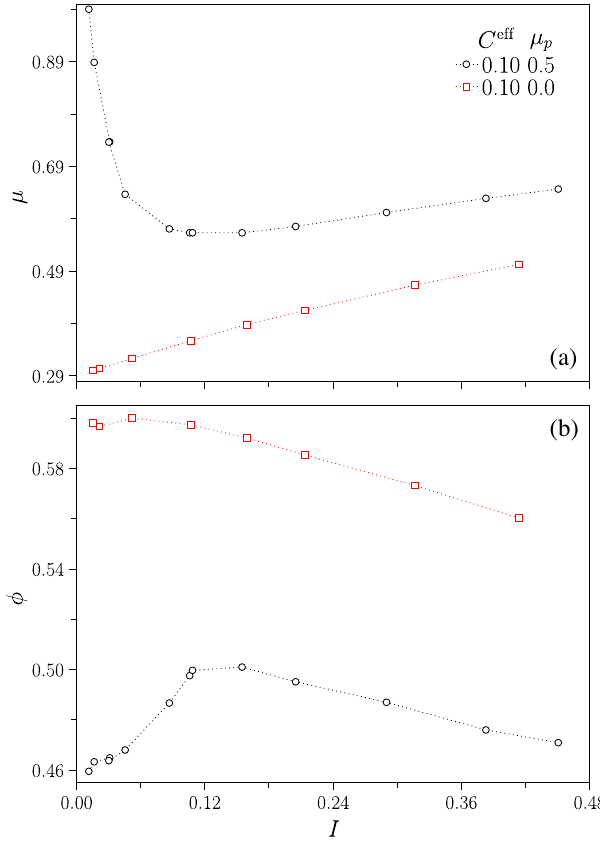
FIG. 7. Effect of the interparticle friction on the constitutive rheological curves. (a) μ ð I Þ and (b) ϕ ð I Þ for μ p ¼ 0 . 5 and μ p ¼ 0 for C eff ¼ 0 . 1